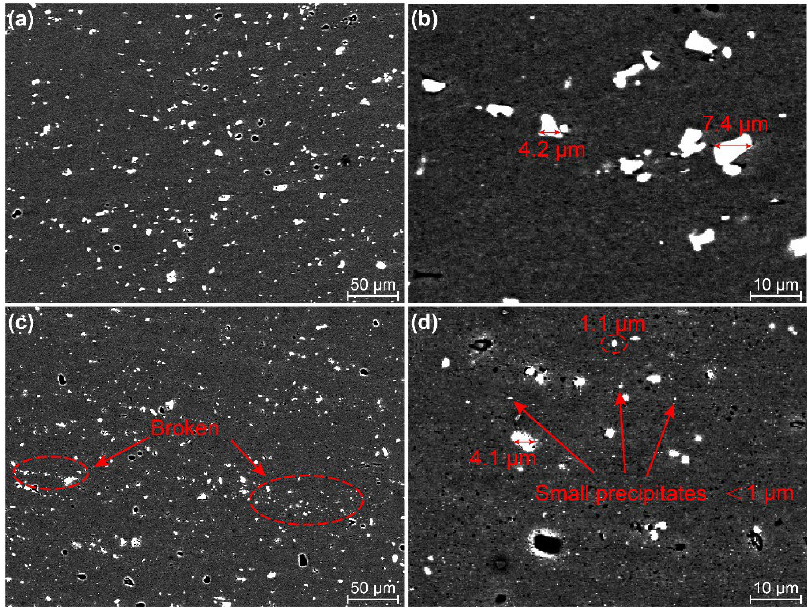
Figure 11. Distribution of precipitates at the bottom WNZ ( a , b ) Pin-1 and ( c , d )